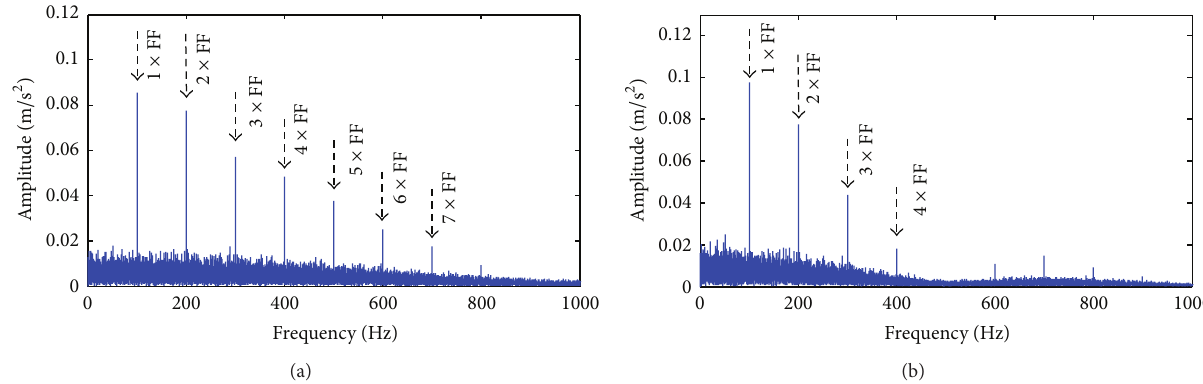
Figure 18: (a) Frequency spectrum of filtered signal by first length of SE; (b) frequency spectrum of filtered signal by second length SE.